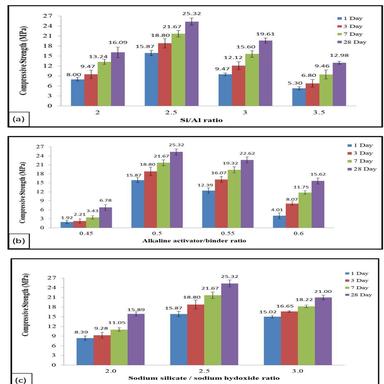
Compressive strength of geopolymer mortar cubes of considered parameters (a) effect of Si/Al ratio (b) effect of alkaline activator solution/binder ratio (c) sodium silicate/sodium hydroxide solution ratio.